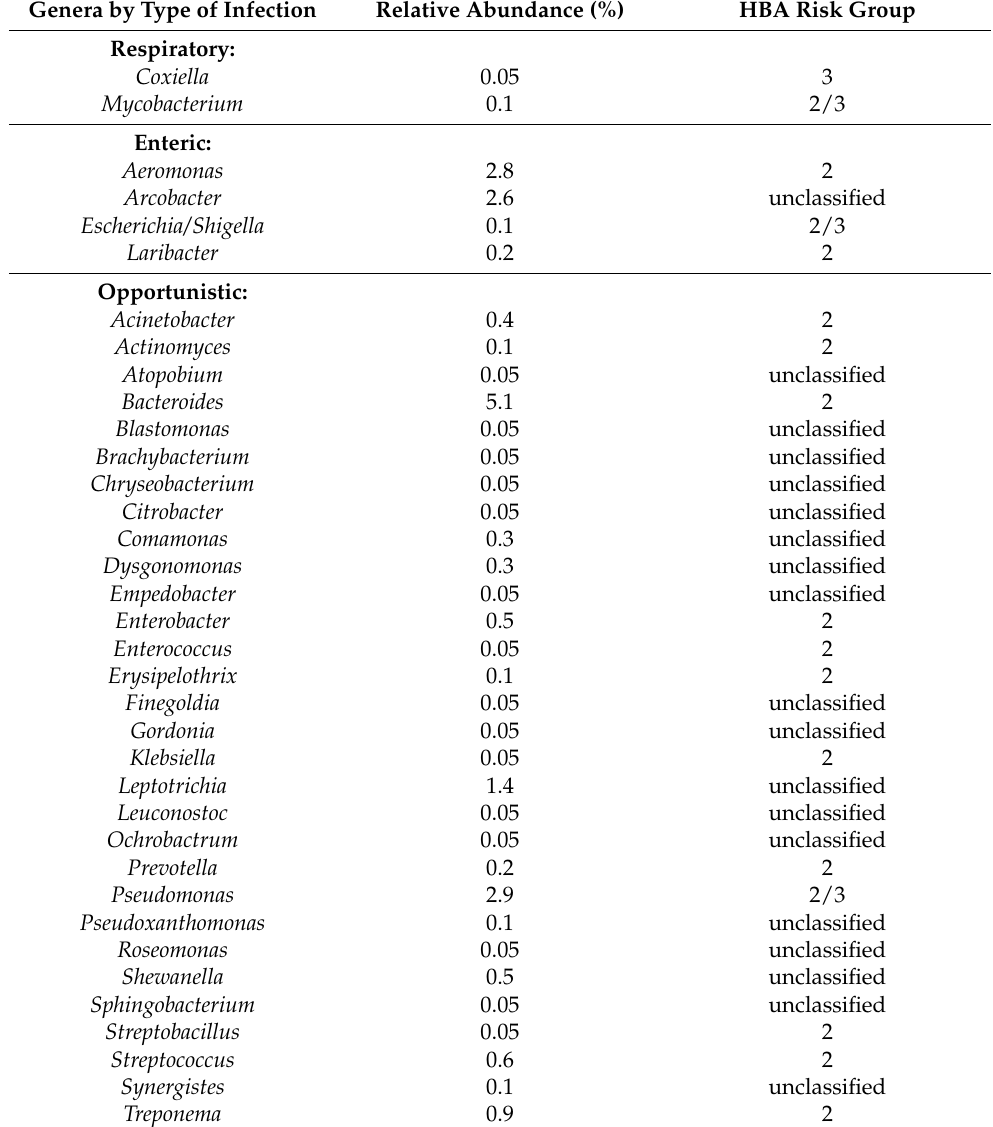
Table 3. Overall relative abundance of pathogenic genera and their risk evaluation by type of